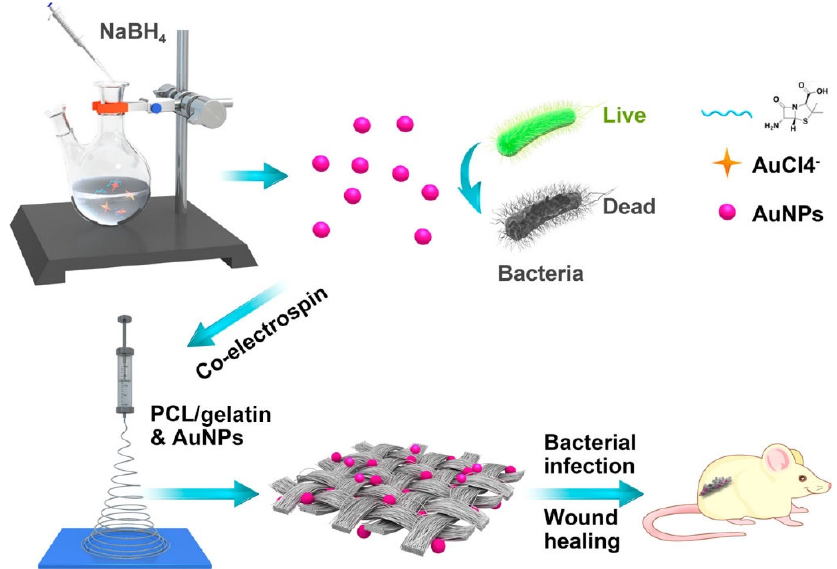
Figure 9. Schematic representation of the synthesis of APA ‐ coated AuNP for wound healing treatment in bacterial infection. Reprinted with permission from [53]. Copyright © 2017 American Chemical Society.